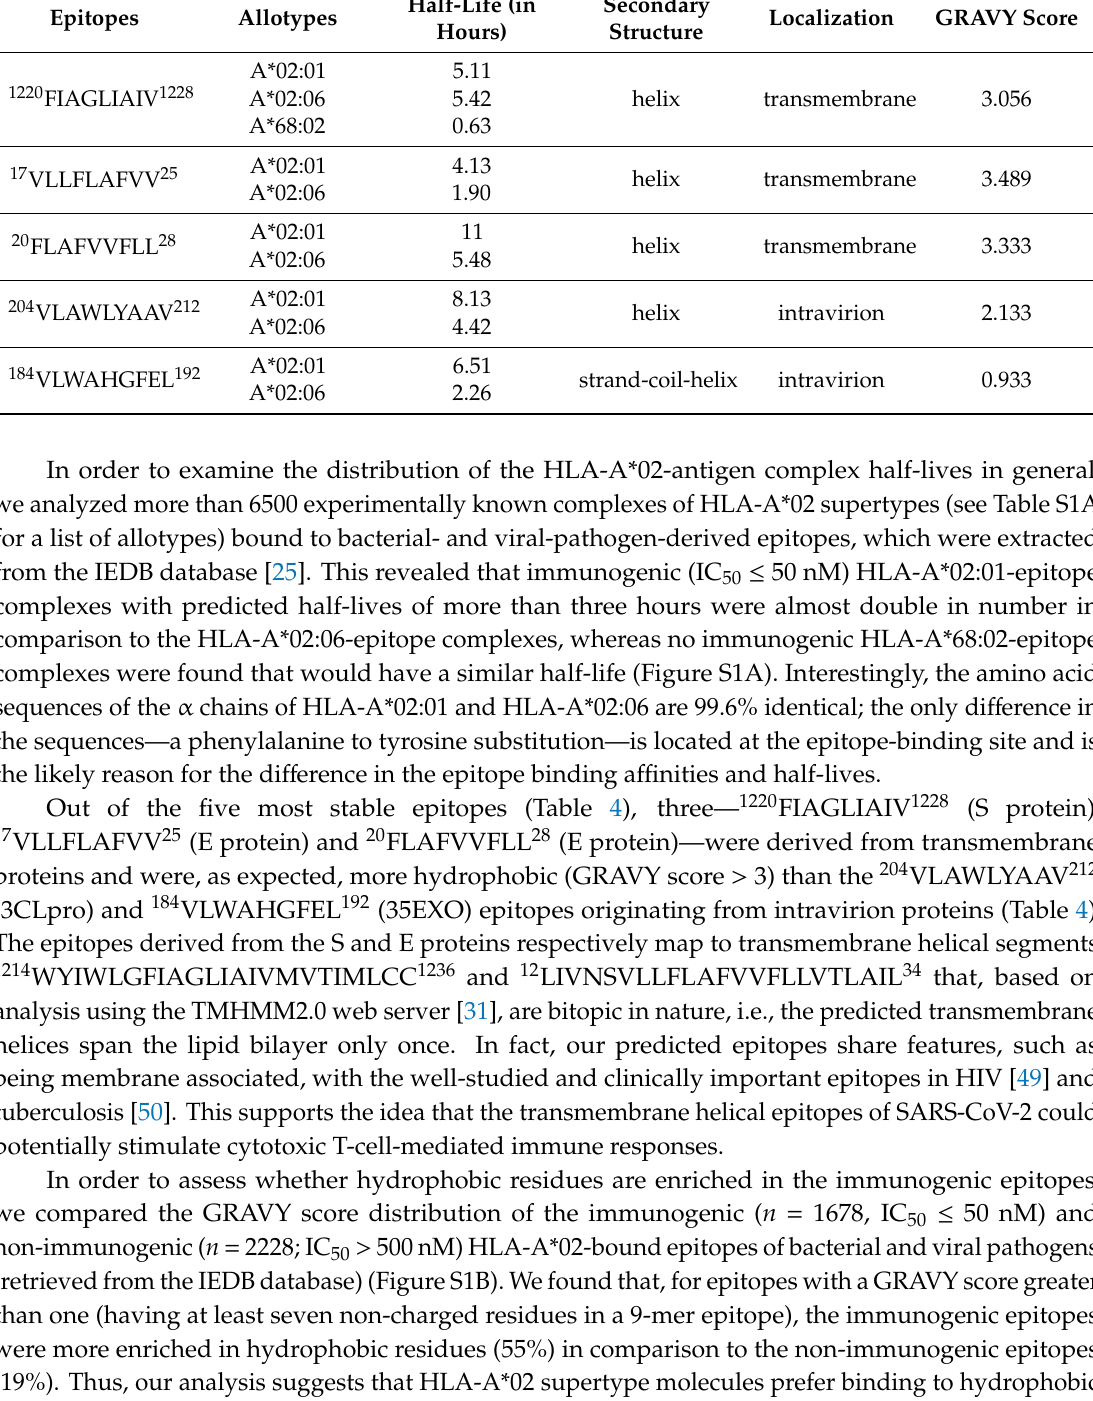
Table 4. Predicted half-lives of complexes of the conserved SARS-CoV-2-derived most immunogenic experimentally identified epitopes and HLA-A*02 allotypes shown in Table 3. Secondary structures, localization within SARS-CoV-2 and GRAVY (grand average of hydropathicity index) scores of the epitopes.